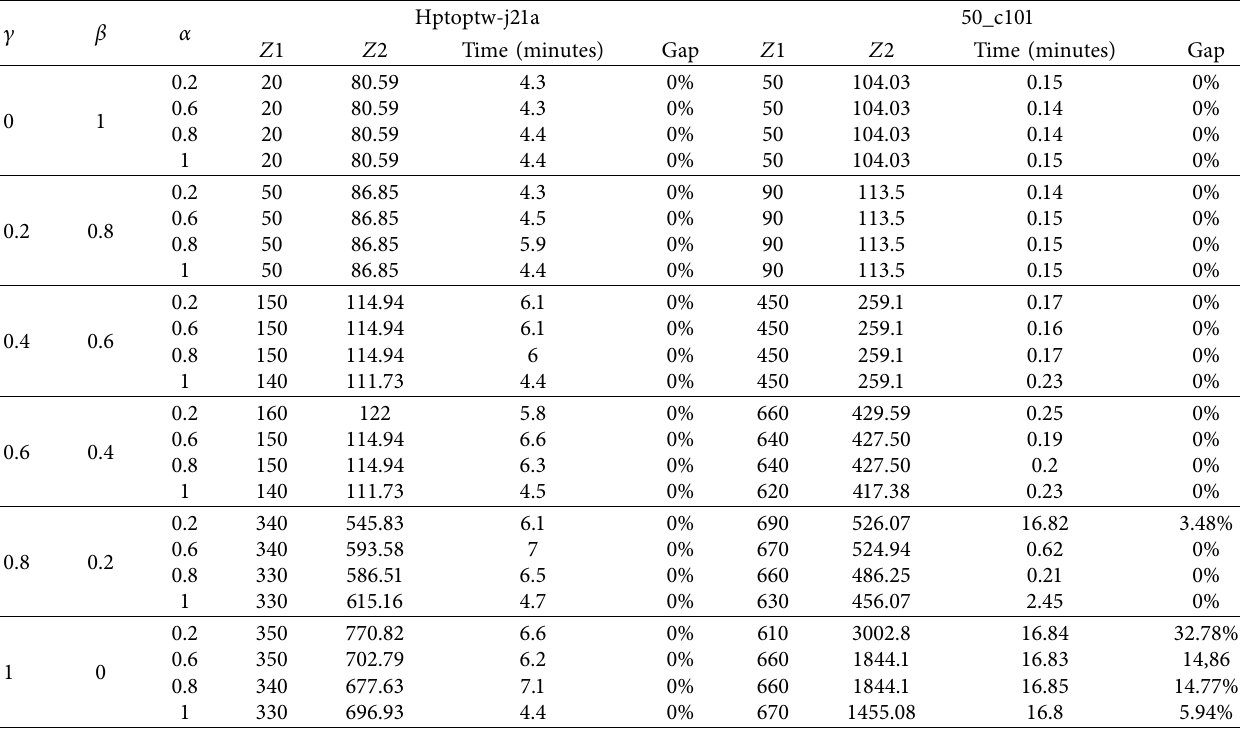
Table 3: Numerical results for hptoptw-j21a and 50_c101 instances.